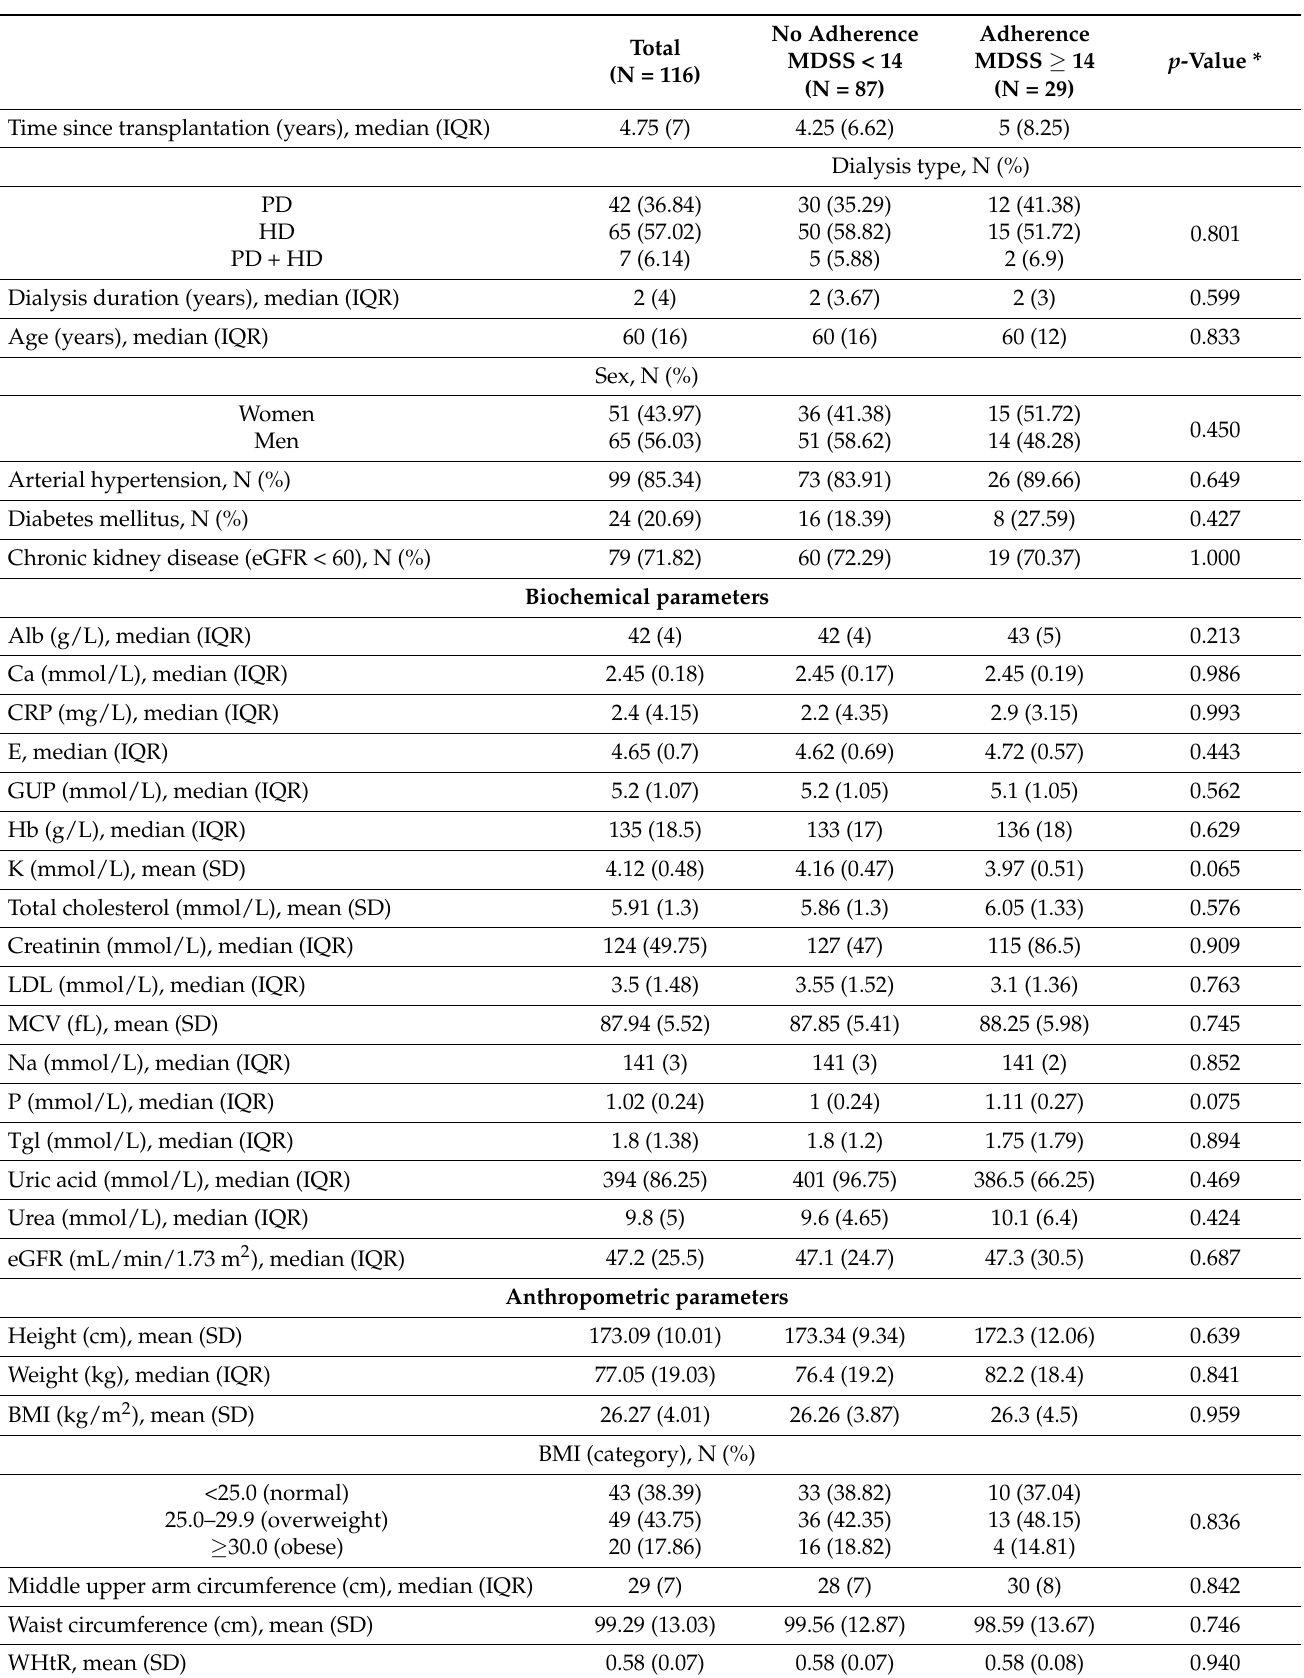
Table 1. Basic characteristic of study population and differences regarding adherence to the